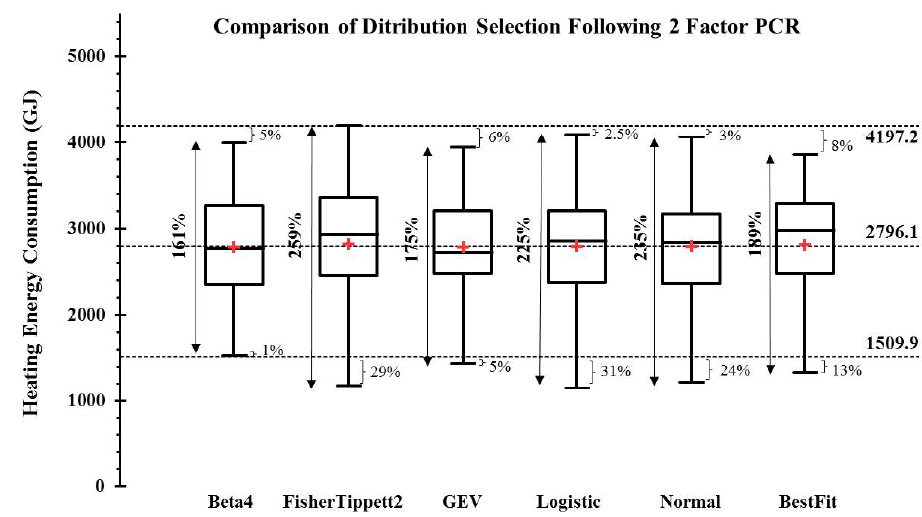
Figure 10. Heating energy use probability density functions when following a 2 Factor Principal Component Regression model and comparing selection of First and Second input principal component distribution series.